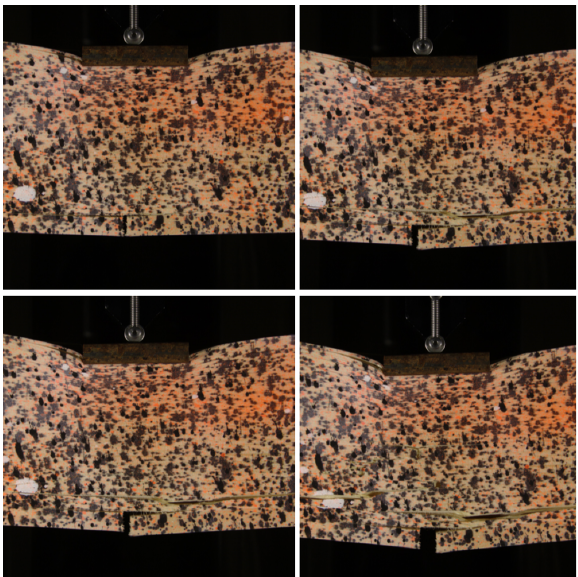
Figure 14. Damage evolution of the beam #11 with the failure F3 - parallel with the grain followed by splinter above the notch.